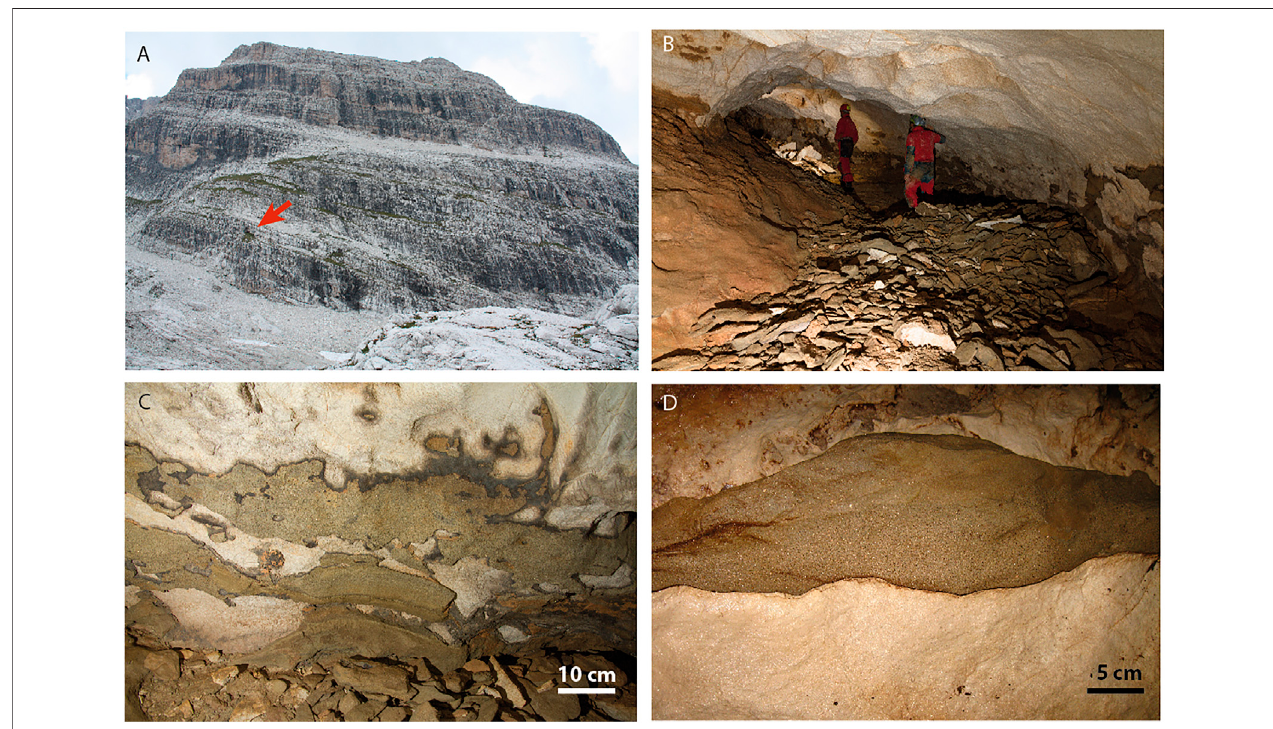
FIGURE 3 | Cave morphologies and sediment: (A) The entrance of the Cave is a gallery truncated by erosion on the cliffs of Cima Grosté (red arrow); (B) Typical paleophreaticconduitwithellipticalshapeandbigscallopsduetophreaticslow fl ow; (C) Remnantsofcementedsandstonesedimentsoncavewalls; (D) Asedimentary fracture in fi lling on the cave roof indicating that the whole gallery was originally fi lled and then